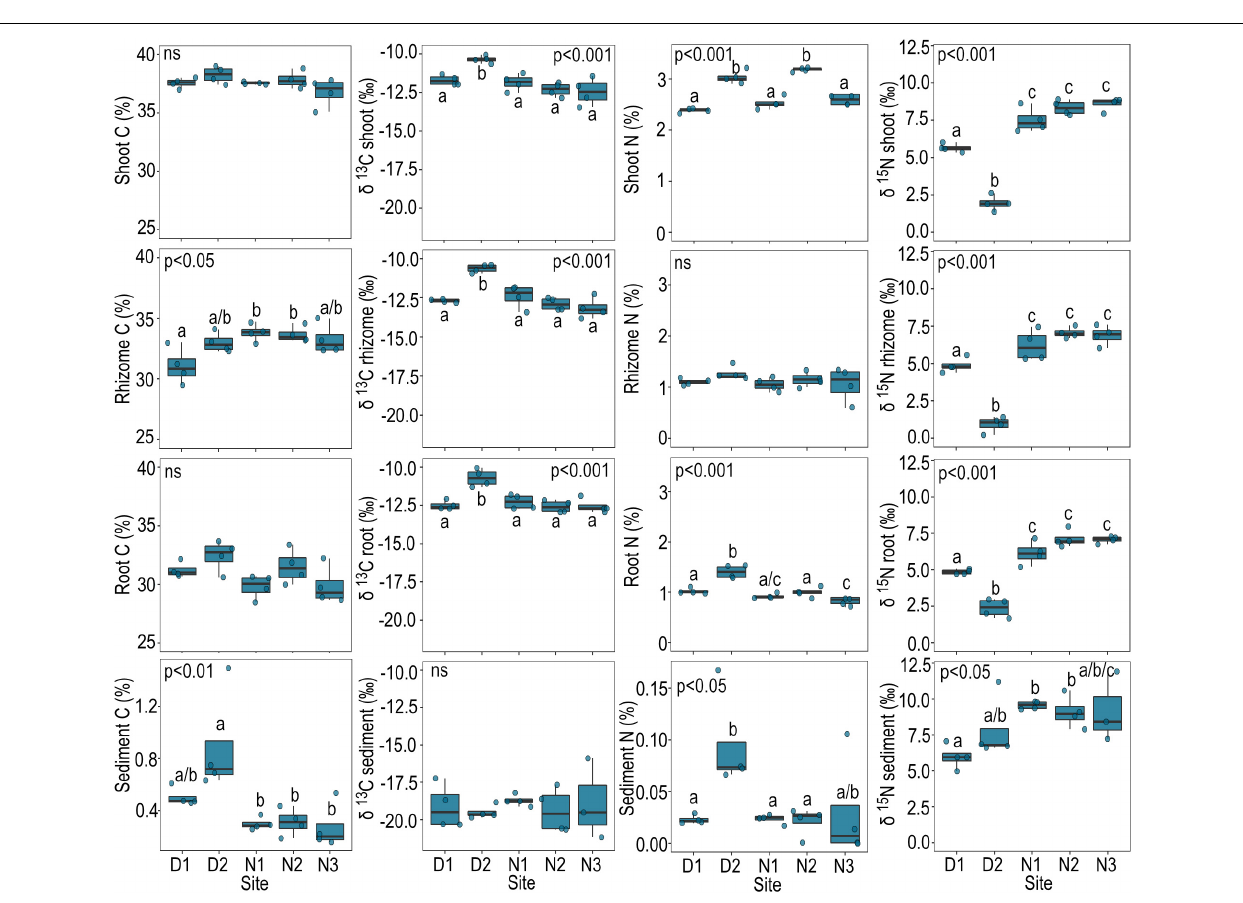
FIGURE 3 | Carbon (%), δ 13 C, nitrogen (%), and δ 15 N of seagrass tissue and sediment by site. Data are boxplots with datapoints overlain. Significant post hoc comparisons are indicated by lowercase letters. Ns, no significant difference among